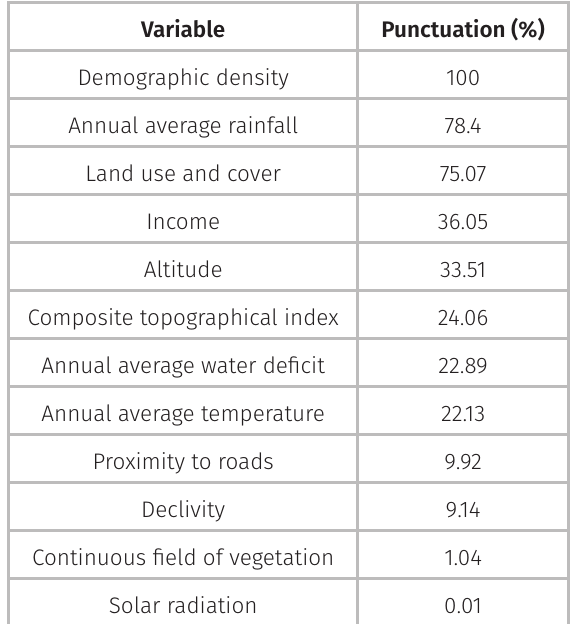
Table II. Punctuation of each variable in the decision tree